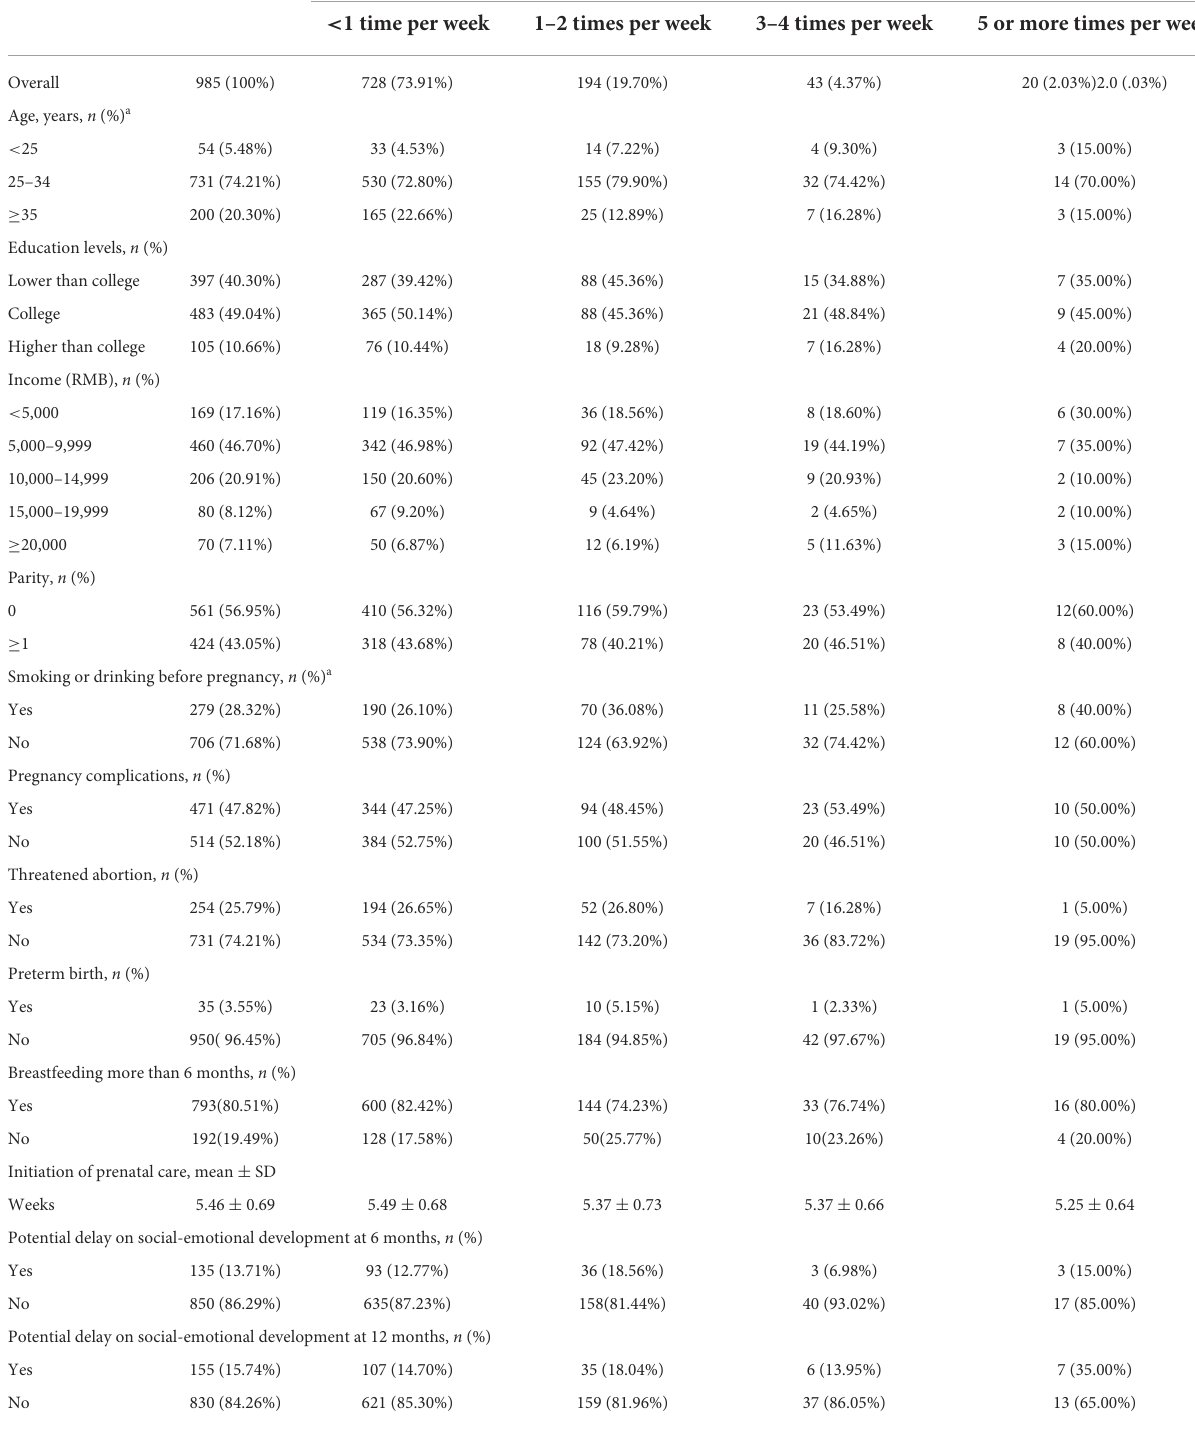
TABLE 1 Characteristics of the study population, according to maternal total sugar-sweetened beverage